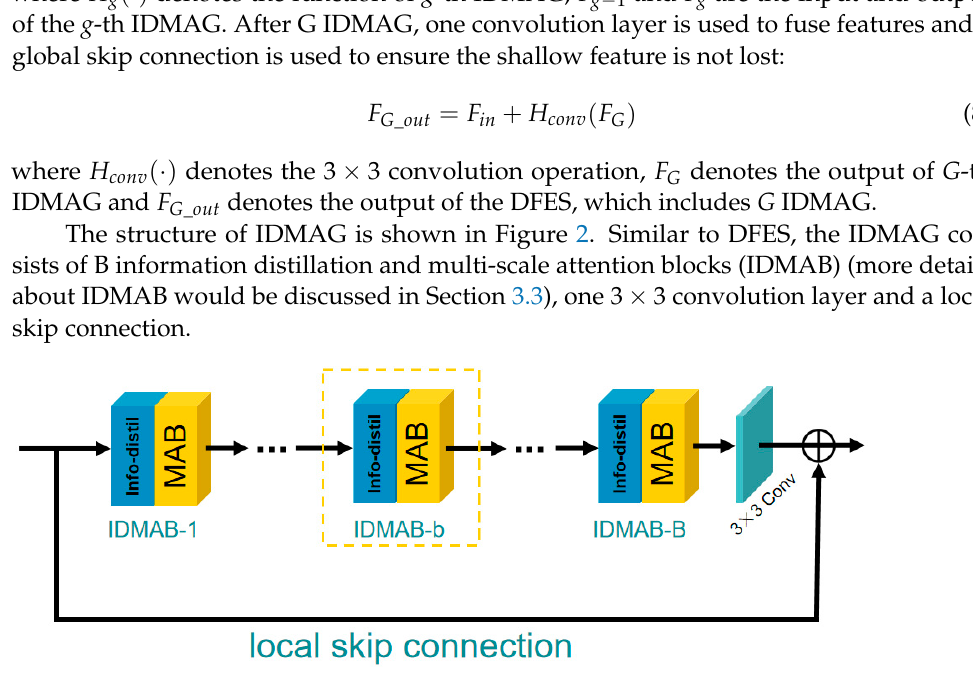
Figure 2. Information distillation and multi-scale attention group (IDMAG).